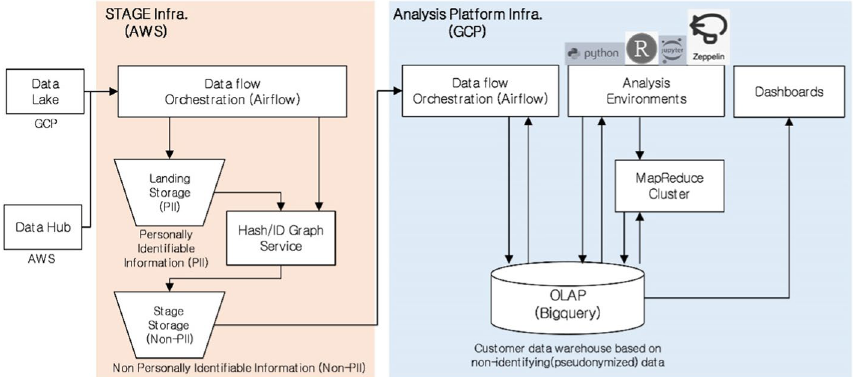
Fig. 2 Big data platform for customer data